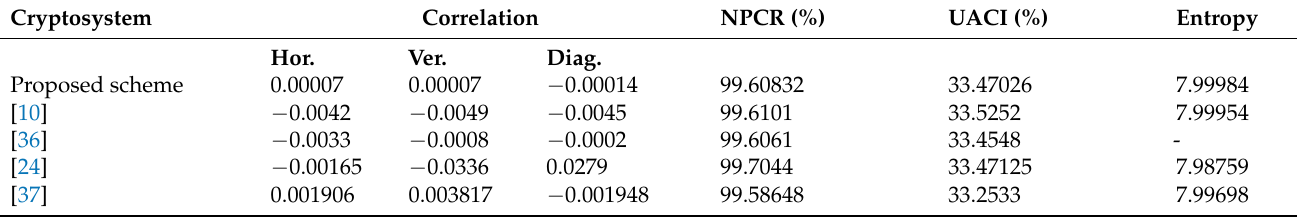
Table 16. Comparative study of the average values of information entropy, correlation coefficients, UACI, and NPCR of the suggested cryptosystem image with respect of other similar cryptosystems. Cryptosystem Correlation NPCR (%) UACI (%) Entropy Hor. Ver. Diag.